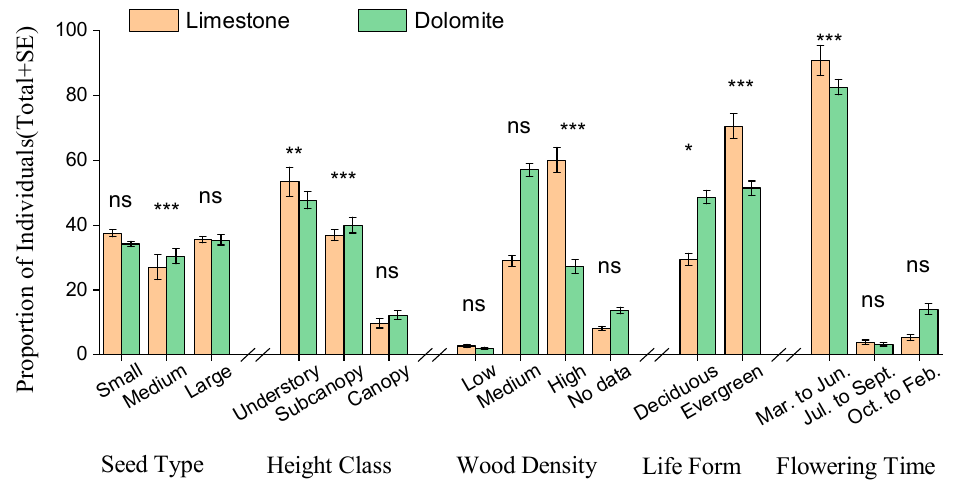
Figure 5. A comparison of the representation of functional traits in tree species (DBH ≥ 3 cm) from dolomite and limestone plots in Southwest China. Mann–Whitney U tests were used to examine proportion data of tree species from 14 dolomite- and 12 limestone-karst-forest plots. Each bar represents total proportion of individuals ± standard error of the mean. The asterisks “***”, “**” and “*” represent the significance levels of 0.001, 0.01 and 0.05, respectively, and “ns” represents nonsignificant levels.